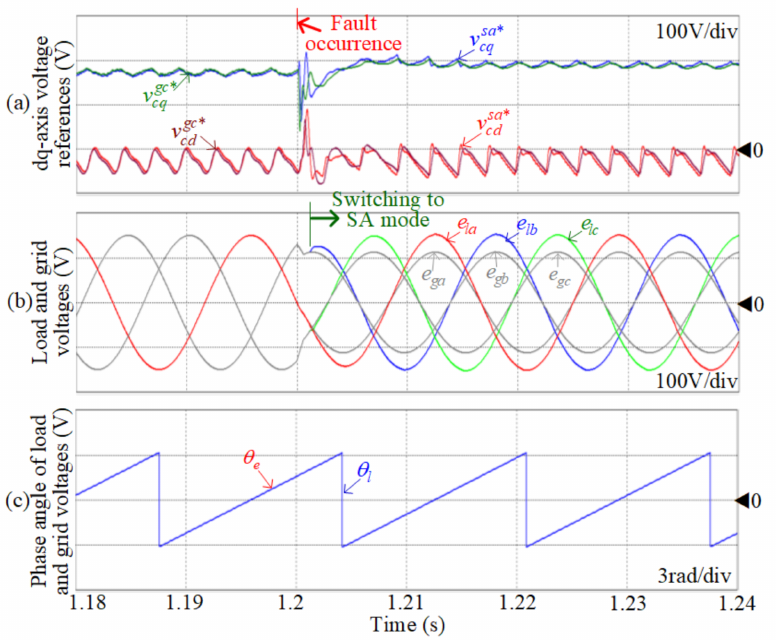
Figure 6. Transition performance from GC operation to SA operation: ( a ) dq -axis voltage references; ( b ) load and grid phase voltages; ( c ) phase